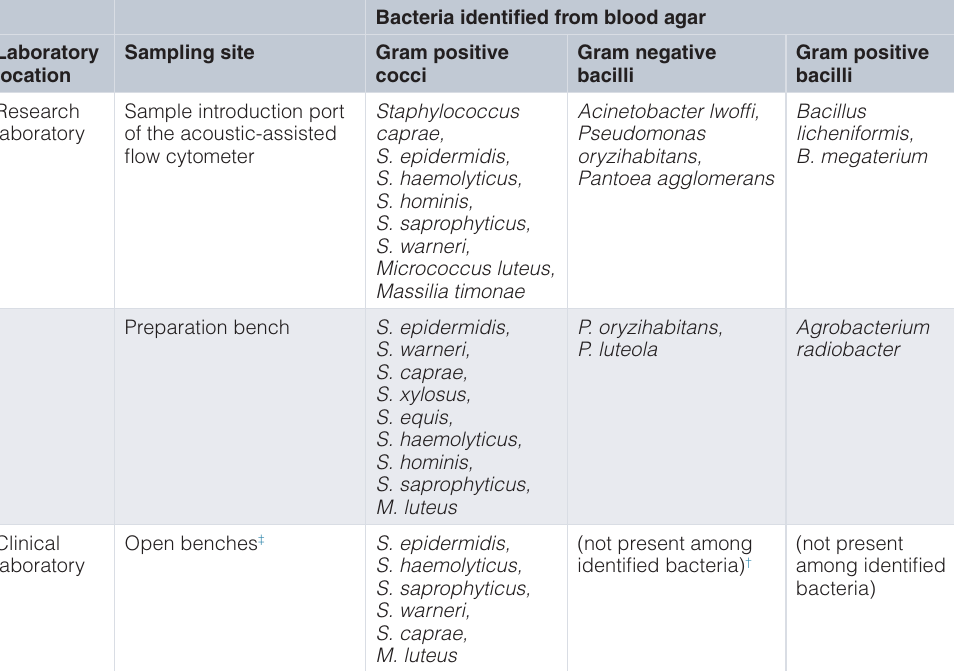
Table 1A. Identities of the commonest bacterial species isolated on blood agar † from 1000 L air samples, arranged by laboratory location. † sampling onto HBA frequently yielded plates crowded with microbial growth. Only the six commonest colony types were identified plus any that resembled the three target bacteria ‡ results from both sampling sites in the clinical laboratory were pooled for this